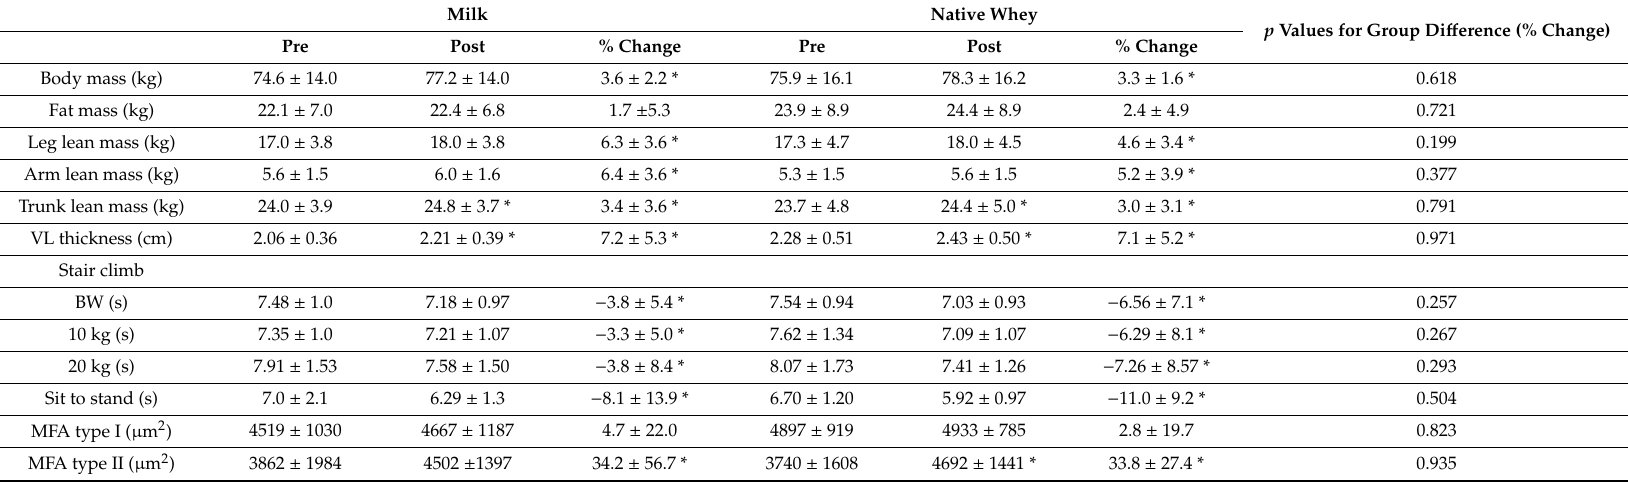
Table 4. Changes in regional muscle mass, m. vastus lateralis thickness, muscle fiber area, and myonuclei in elderly men and women receiving milk or native whey supplementation for 11 weeks combined with strength training. Milk Native Whey